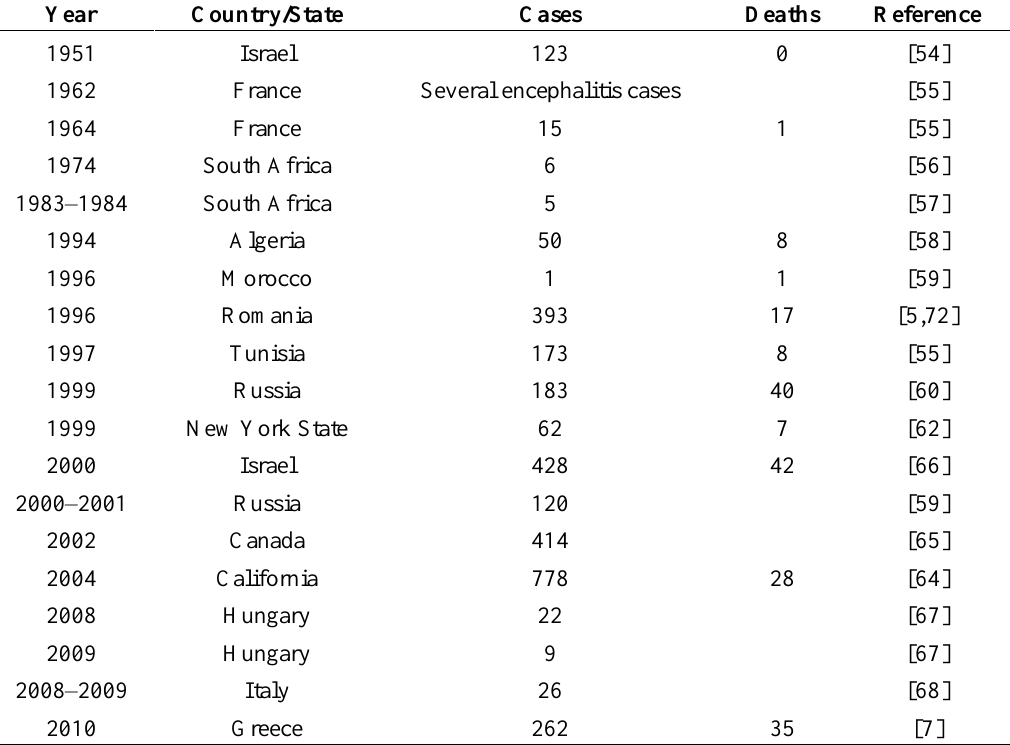
Table 1. The most significant WNV human outbreaks worldwide,